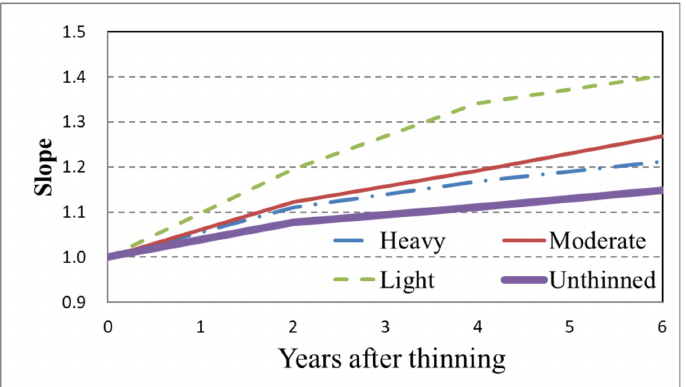
Figure 3. Variation of DBH growth slope during 6 years of 14-year old mahogany with four thinning